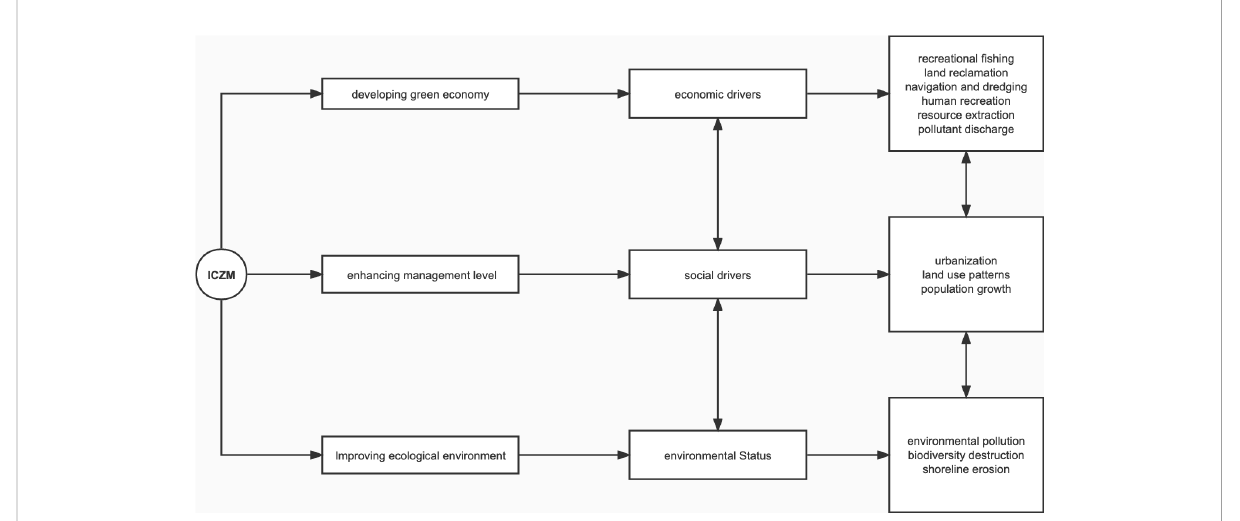
FIGURE 1 Interaction mechanisms of coastal zone complex